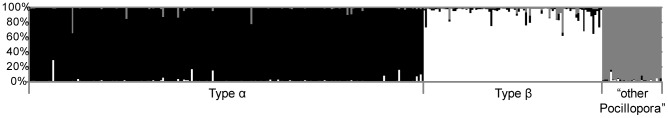
STRUCTURE plot (K = 3) of 329 Pocillopora damicornis sensu
[10] specimens from Lizard Island.Genetic lineage was determined by the PCR RFLP assay.